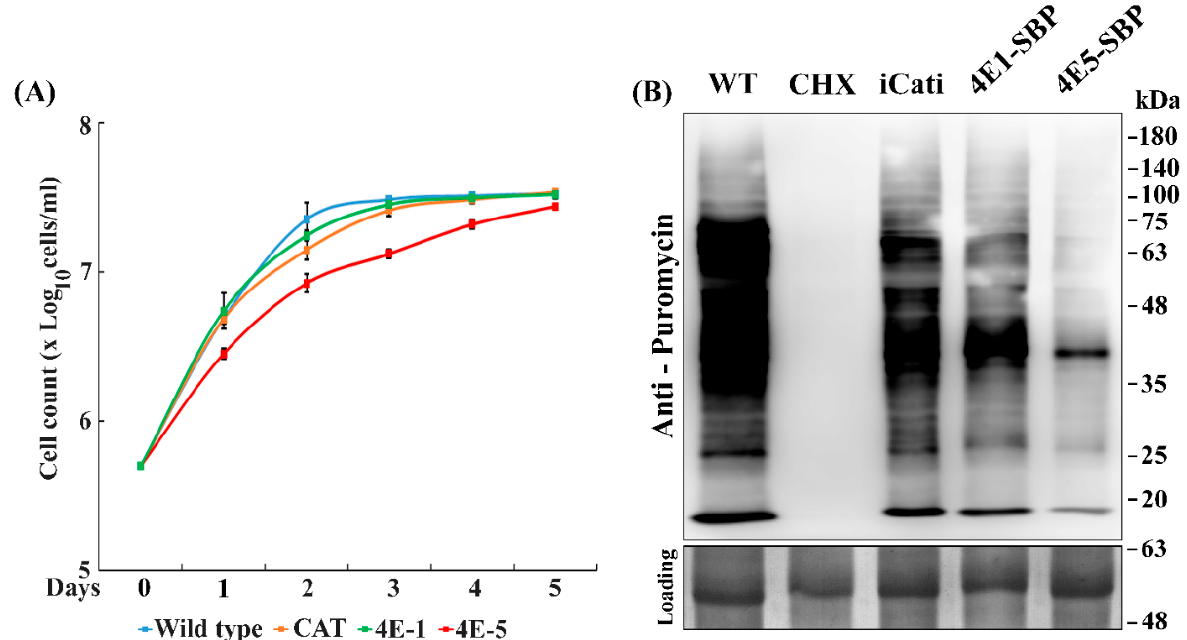
Figure 2. Episomal expression of LeishIF4E-5 affects global translation and growth. Wild type L. amazonensis, transgenic L. amazonensis promastigotes expressing chloramphenicol acetyltransferase (CAT), SBP-tagged LeishIF4E-5 and SBP-tagged LeishIF4E-1 were grown under normal conditions. ( A ) Cell counts were taken during 5 days. Cells expressing LeishIF4E-5 tagged with the streptavidin binding peptide, SBP (4E5-SBP), are shown in red, LeishIF4E-1-SBP cells are shown in green, cells expressing the CAT reporter are shown in orange and wild type cells are shown in blue. Cell growth is represented by log 10 cells/mL against the number of days, taken in triplicates. Lines were drawn based on the mean values of the different experiments with standard errors. ( B ) Cells were incubated with 1 µ g/mL puromycin for 20 min, extracted proteins were separated over 12% SDS-PAGE and subjected to Western analysis using specific antibodies against puromycin. A cycloheximide (CHX) control for complete translation inhibition is also shown. The different lanes contain equal protein loads, as shown by the Ponceau staining (bottom panel). The experiment was repeated three times and the densitometric analysis is given in Figure S 3 .